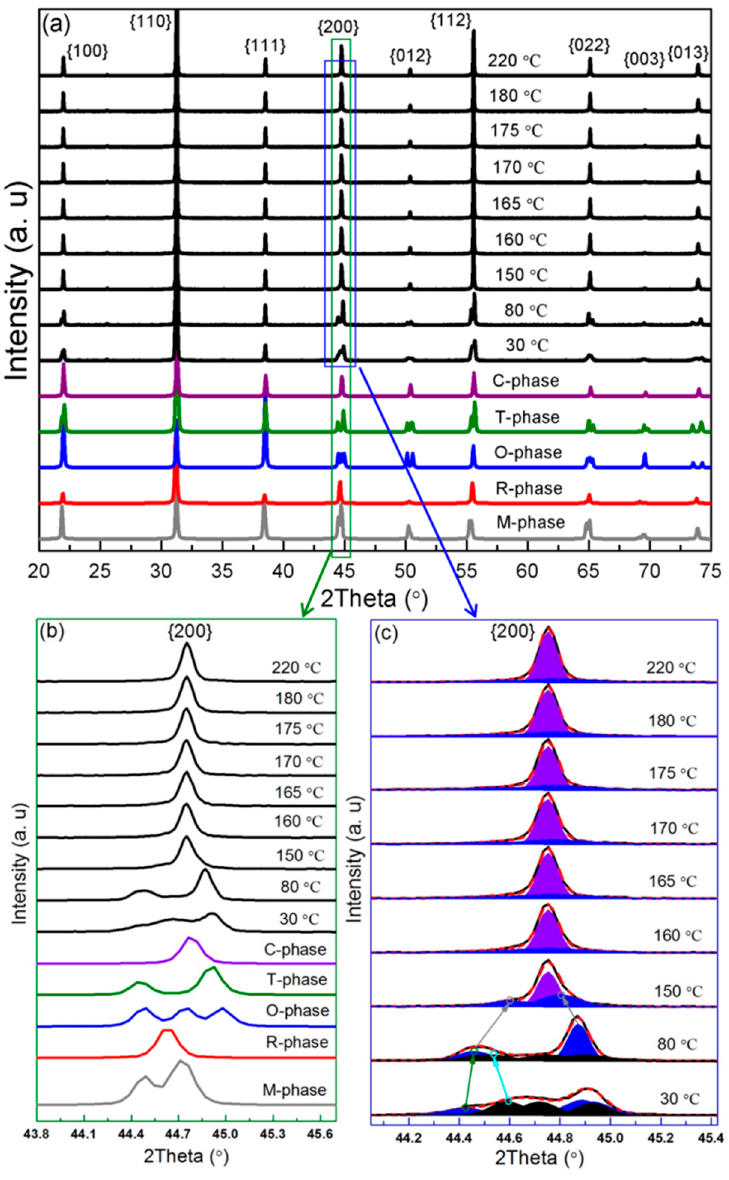
Figure 1. ( a ) The temperature dependent XRD patterns of PZN-9PT single crystals from 30 to 220 °C. Simulated XRD patterns (color lines at the bottom of Figure 1a) for pure monoclinic ( M C ), rhombohedral ( R ), orthorhombic ( O ), tetragonal ( T ), and cubic ( C ) phase of PZN-9PT are also illustrated; ( b , c ) The amplified curves around {200} with fitting results.